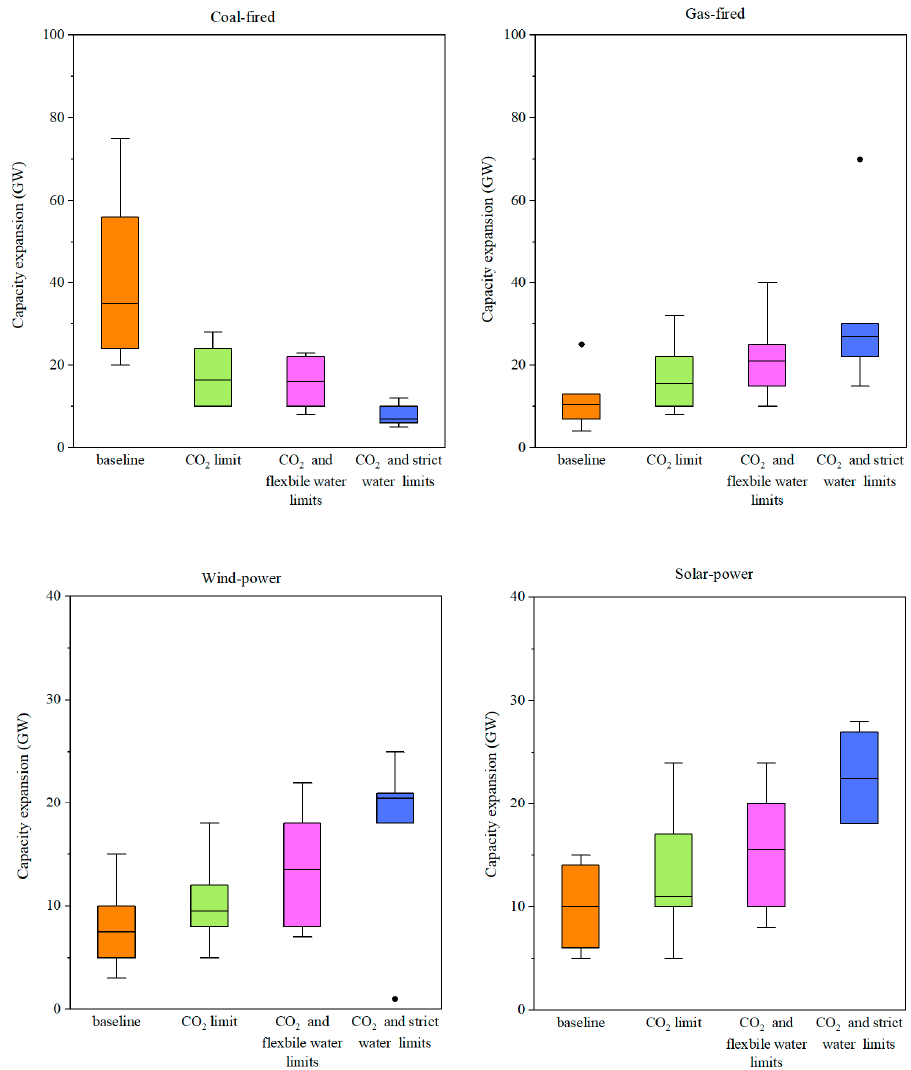
Figure 7. The capacity expansion under mixed scenarios.